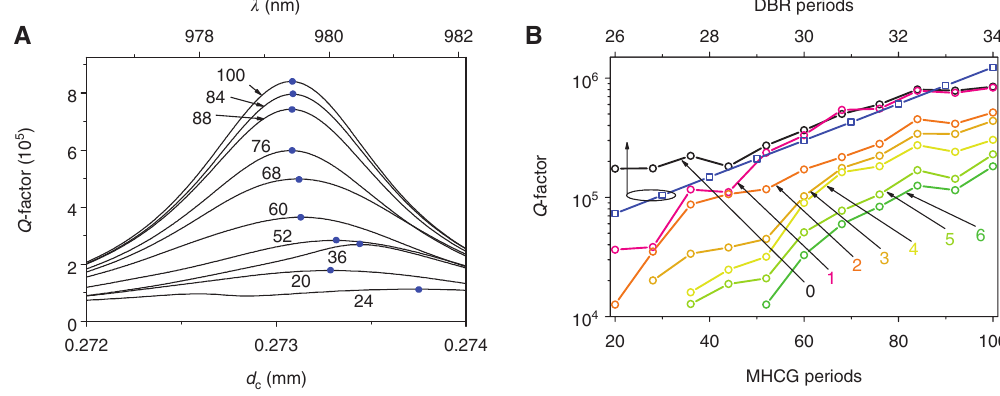
Figure 6: (A) Q -factor of the M-M microcavity when both of the MHCG mirrors have the same, variable number of stripes from 20 to 100 as a function of the microcavity thickness ( d ) and the resonant wavelength ( λ ) of the fundamental mode. The blue dots represent the maxima c of the Q -factor for a given number of MHCG stripes. (B) Q -factor of the seven lowest order modes of the M-M microcavity as a function of the number of MHCG stripes (colored lines, bottom axis) and Q -factor of a D-D cavity as a function of the number of top and bottom DBRs periods (blue line, top